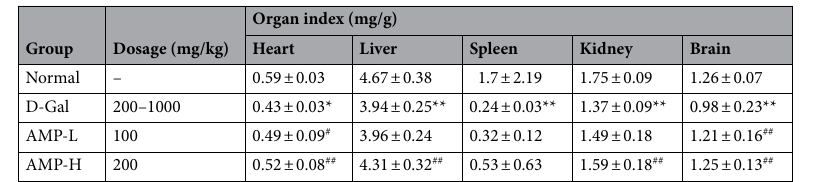
Table 2. Effect of AMP on the organ index of aging mice. Values represent the mean ± S.D., n = 10. *p < 0.05 or **p < 0.01 vs. normal group; # p < 0.05 or ## p < 0.01 vs. D-Gal group. The table was drawn using Microsoft